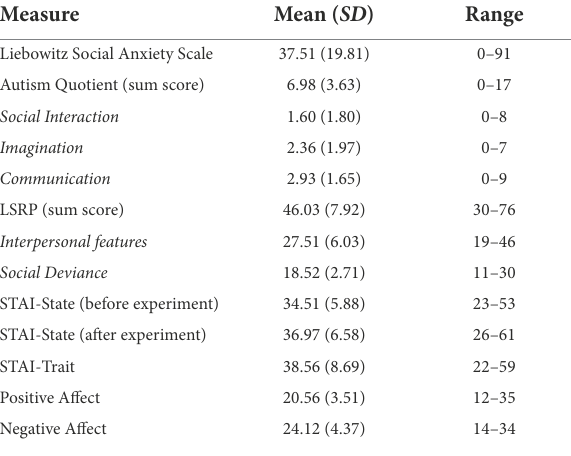
TABLE 1 Psychometric measures across all participants depicting means (standard deviations) and ranges for each assessed